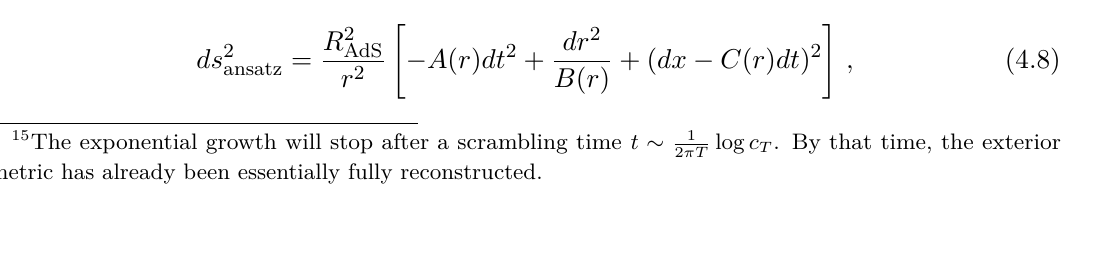
lateral movement to angular